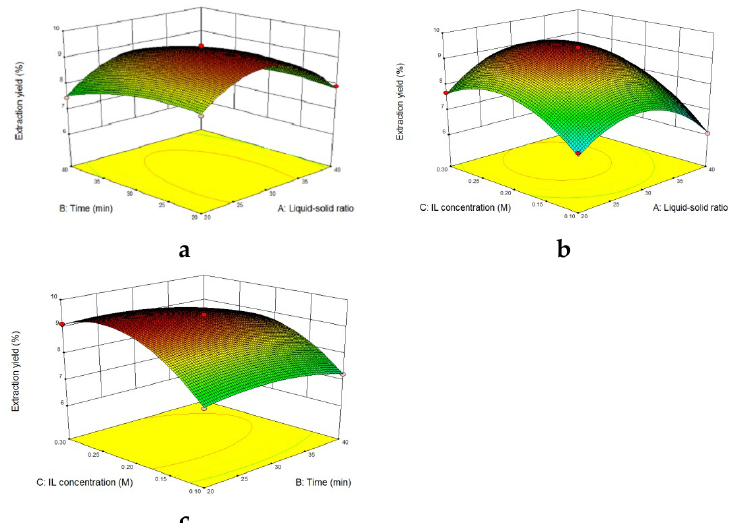
Figure 3. Response surface and contour plots presenting effects of liquid-solid ratio, time, and IL concentration on extraction yields of total ginsenosides using IL-UAE. ( a ) liquid-solid ratio and time; ( b ) liquid-solid ratio and IL concentration; ( c ) time and IL concentration.